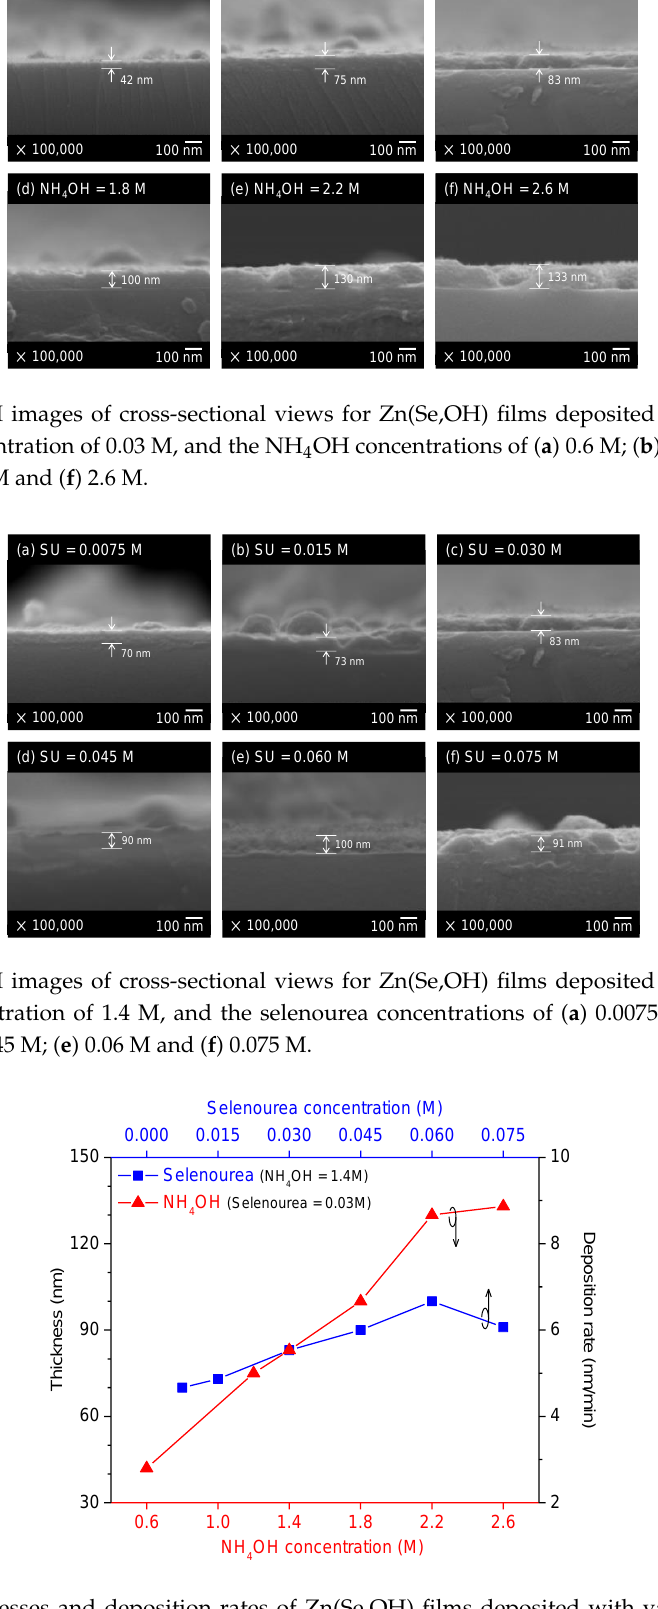
Figure 5. Thicknesses and deposition rates of Zn(Se,OH) films deposited with various ammonia concentrations and selenourea